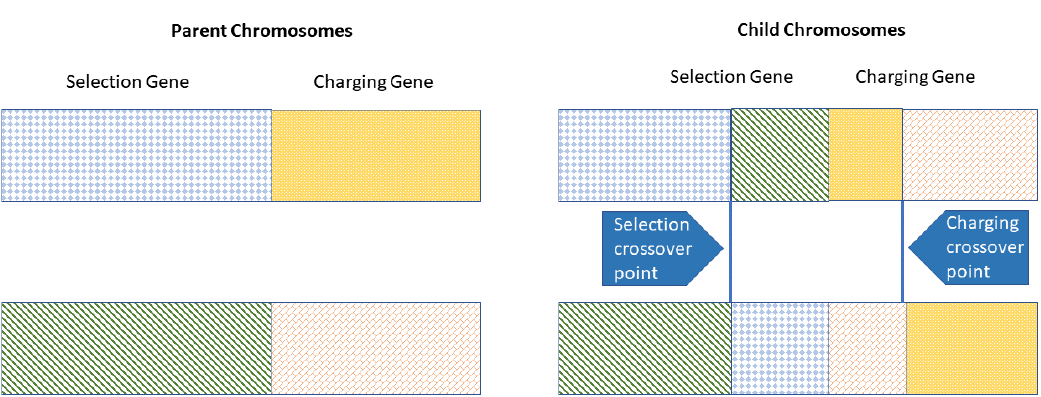
Figure 2. Visualization of the variable-to-variable crossover operation with random crossover points for the selection variable/gene and the charging strategy